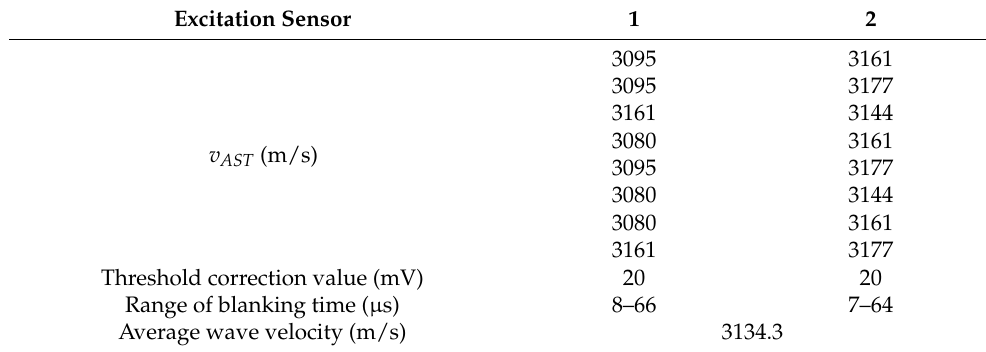
Figure 7. ( a ) AE waveforms containing crosstalk signals; ( b ) AE waveform of the crosstalk signal after the blanking process. Table 2. Measurement results of the wave velocity by the AST method.